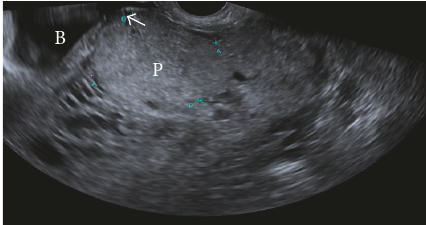
Figure 1: Retained placental tissue (P), 55 mm in diameter. Mini- mal myometrium noted between bladder (B) and placental tissue (arrowed).